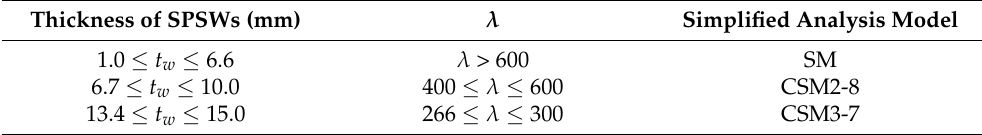
Table 2. Simplified analysis model of SPSW with different λ .